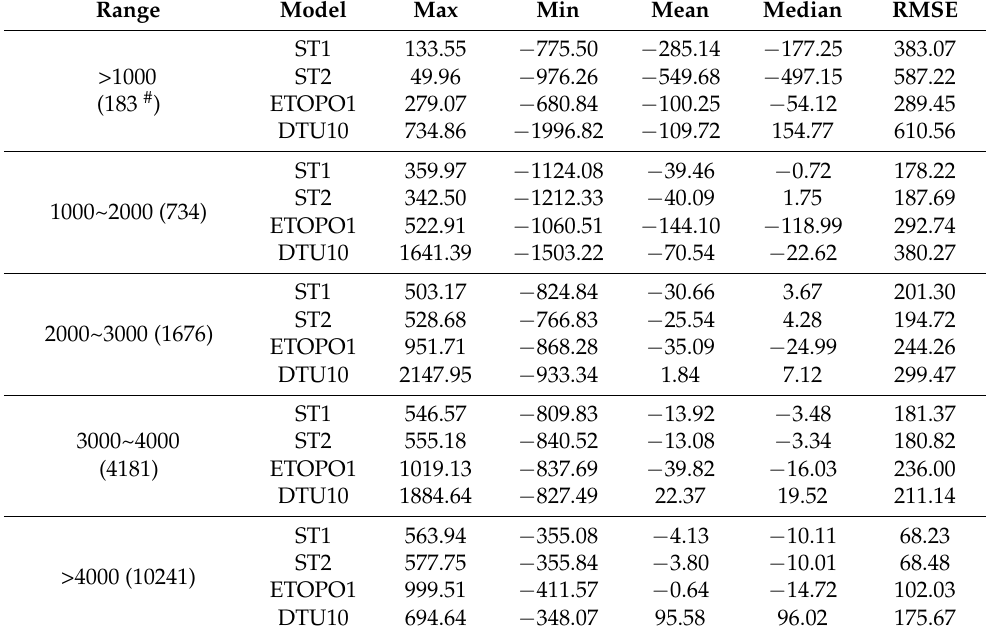
Figure 9. Accuracy variation curve with depth. The black square line is for the ST1, the red circular line is for the ST2, the blue triangular line is for the ETOPO1 model, and the green star-shaped line is for the DTU10 model. Table 3. Statistical results of the differences between the models and check data in different depth ranges. Unit: